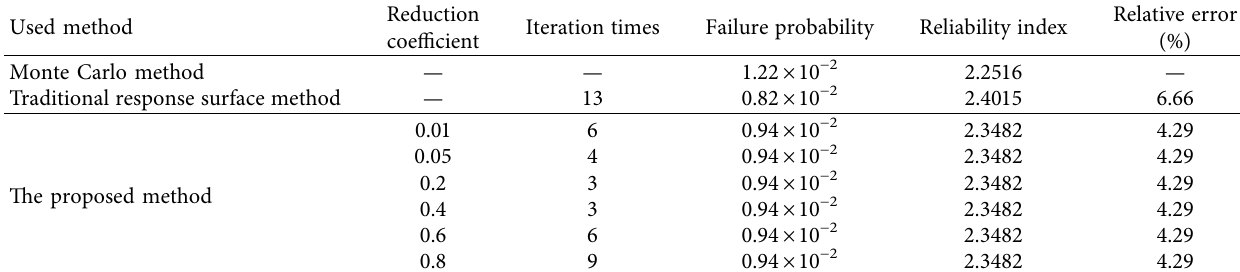
Table 4: Calculation results of example